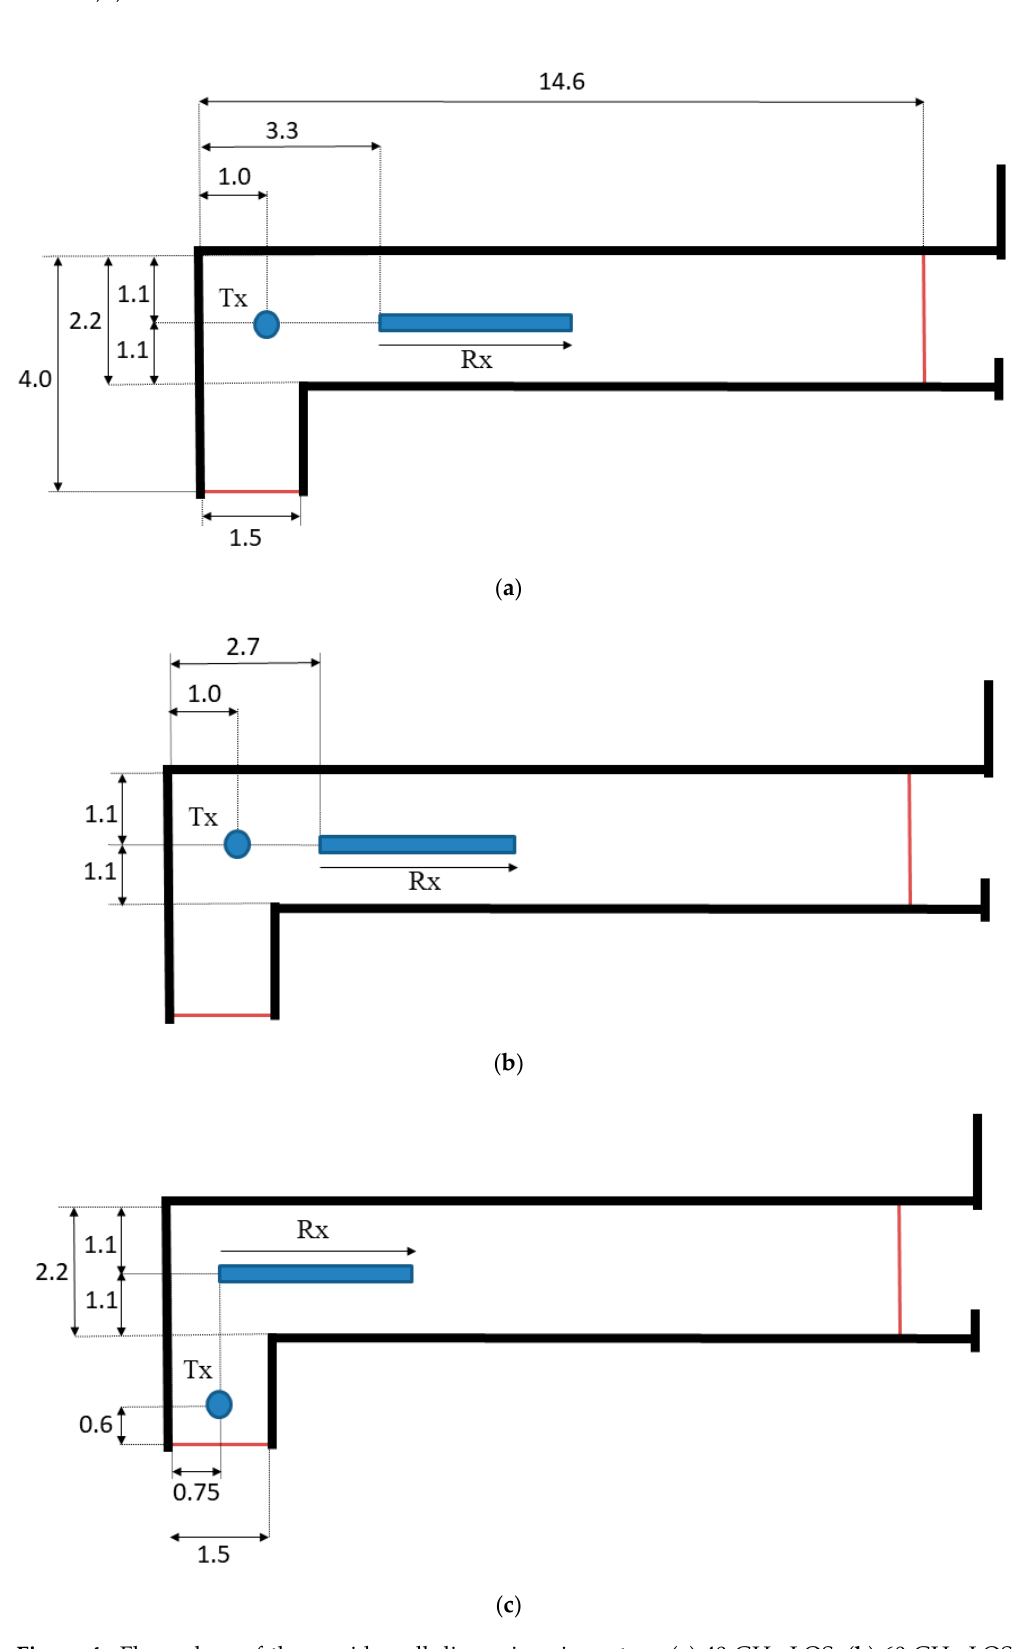
Figure 4. Floor plans of the corridor, all dimensions in meters; ( a ) 40 GHz LOS, ( b ) 60 GHz LOS, ( c ) OLOS.